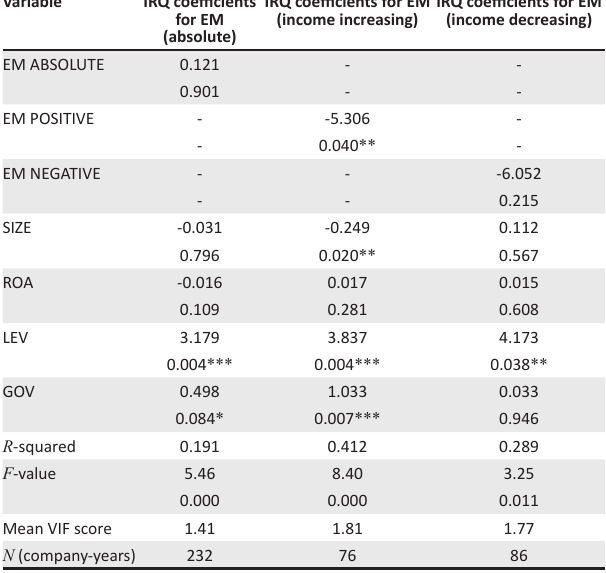
Note: Table 6 presents coefficient estimates for the main empirical model: Equation 1. Two-tailed p -values are reported in parentheses. We discern between absolute discretionary accruals (EM ABSOLUTE), income-increasing discretionary accruals (EM POSTIVE) and income-decreasing discretionary accruals (EM NEGATIVE). The sample for EM ABSOLUTE, EM POSTIVE and EM NEGATIVE includes 232, 76 and 86 company-year observations, respectively. For each analysis the original sample size was reduced with the number of company-years where the absolute studentised residual was more than two. All variables are defined in-text above in the sample selection and research design section and summarised in Appendix 1. For concision the coefficients on the control variable YEAR are not reported. IRQ, integrated report quality; EM, earnings management; SIZE, company size; ROA, return on assets; LEV, company leverage; GOV, corporate governance; VIF, variation inflation factor. *** , ** and * indicate that values are significant at 1 % , 5 % and 10 % levels,